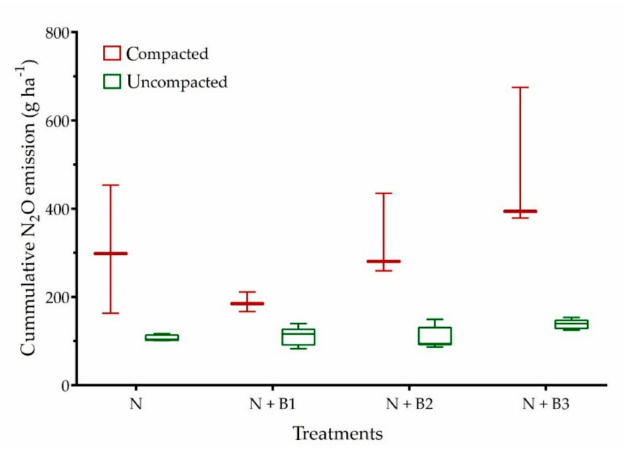
Figure 1. Cumulative N 2 O emissions, box plots show median, percentiles, error bars confidence intervals. Soil addition treatments: N—nitrogen fertilisation, B1—softwood from spruce (mixture of branches and wood chips) biochar, B2—digestate biochar, and B3—wood pallets from softwood (spruce without bark) biochar.